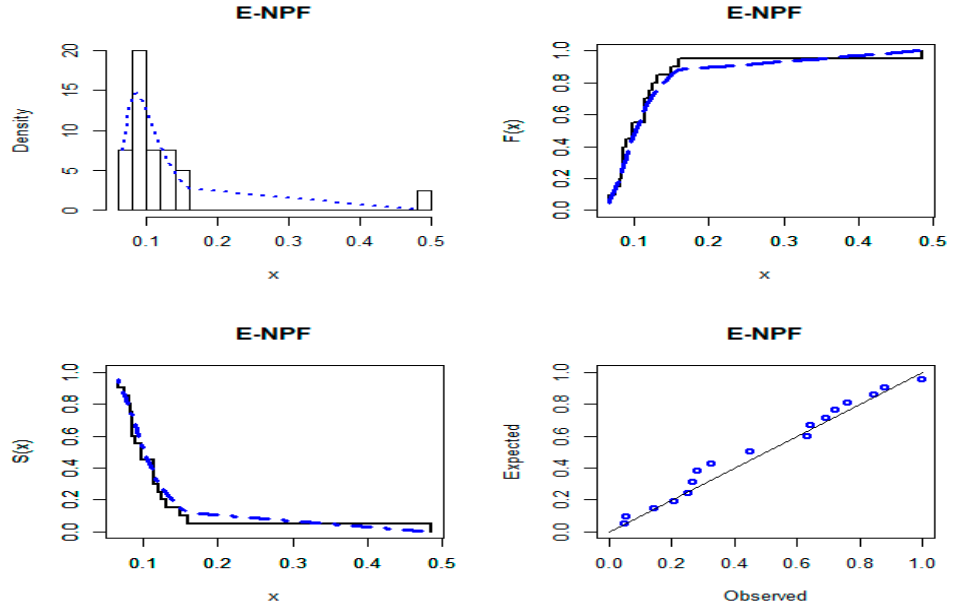
Figure 7. Curves of the E-NPF distribution for mechanical component data.